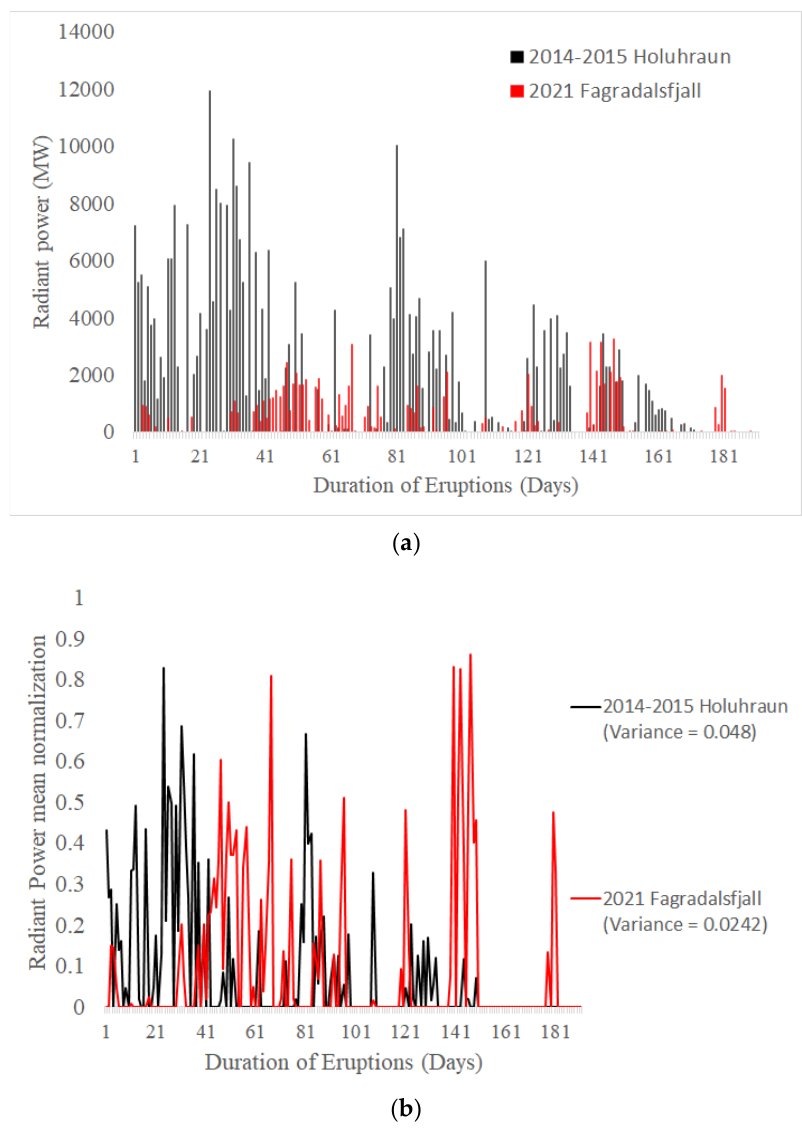
Figure 5. ( a ) Radiant flux comparison from the 2021 Fagradalsfjall (red) and the 2014 – 2015 Holuhraun eruption (black); ( b ) mean normalization and variance of radiant flux comparison from the 2021 Fagradalsfjall (red) and the 2014 – 2015 Holuhraun eruption (black).